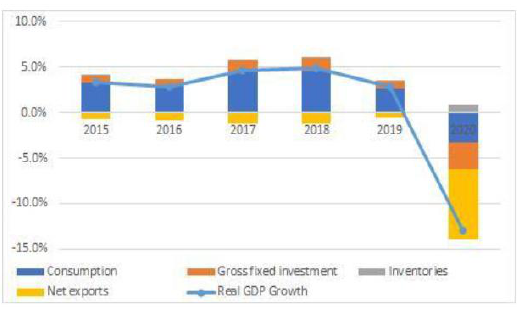
Figure 1: Decline in Economic Indicators Due to the Pandemic (Source: UNCT 2021b, 7)